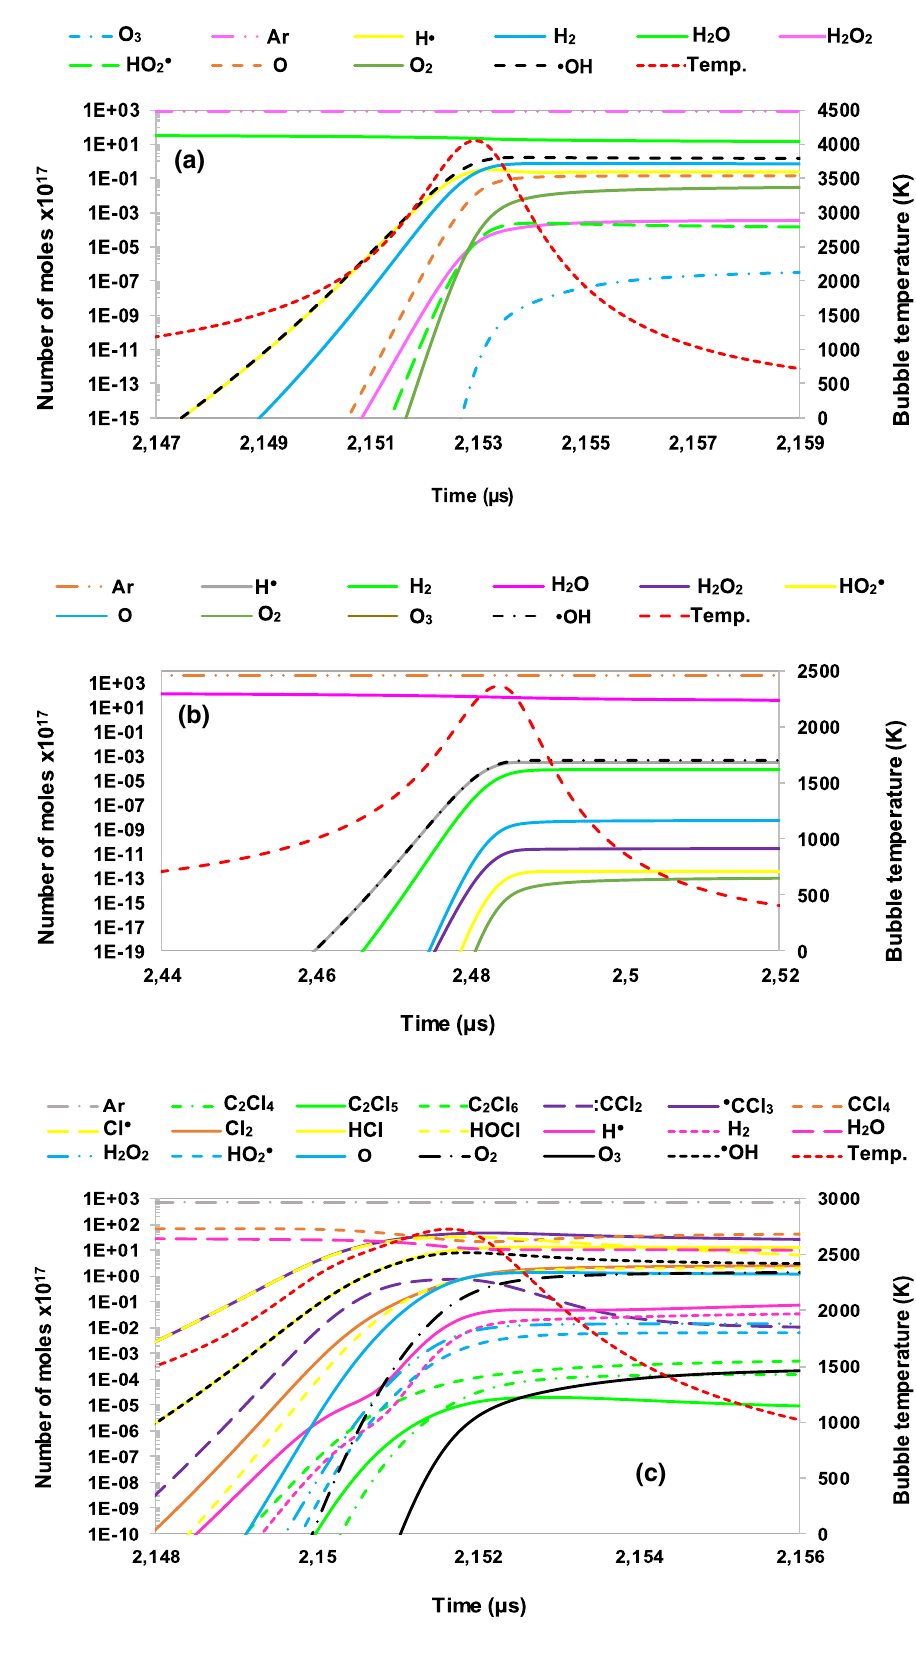
Fig. 1 Evolution of the reac- tions system inside the bubble as a function of time at around the end of the bubble collapse. a and b argon bubble (0 mM of CCl 4 in solution) for initial radii ( R 0 ) of 3.2 a and 6 µm b , respectively. c and d argon bubble in presence of CCl 4 in the solution (5.2 mM) for initial radii ( R 0 ) of 3.2